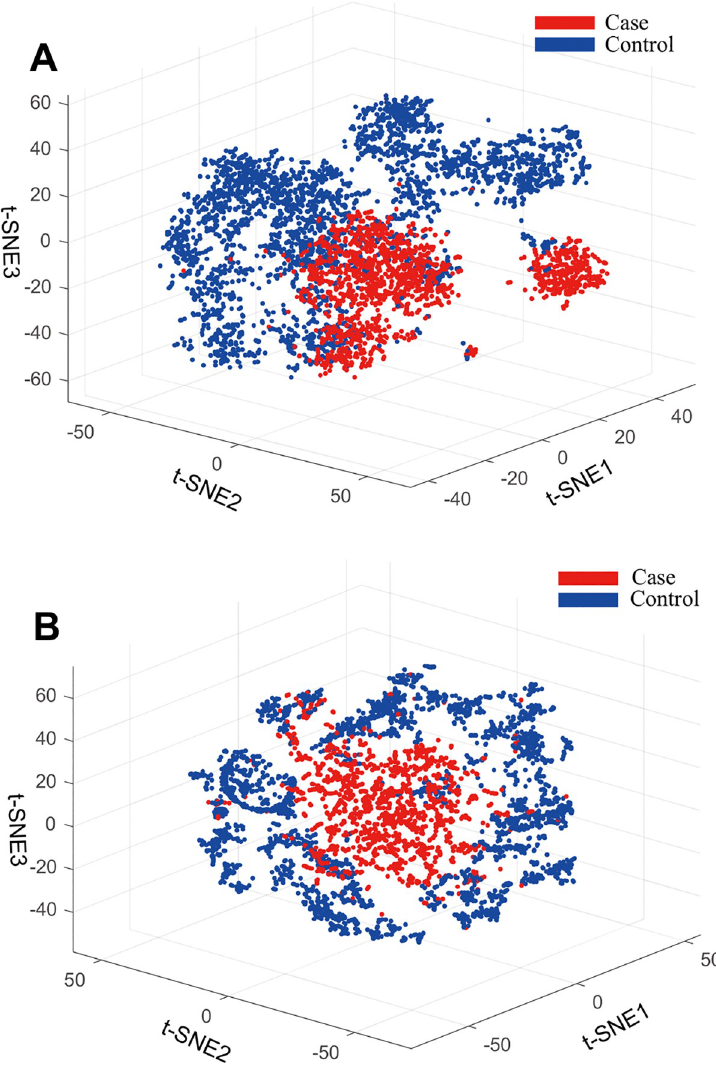
Fig 2. Batch effect elimination by COAC evaluated by a t-SNE algorithm [9]. ( A ) A significant batch effect elimination (Cells distribute separately in different groups) based on the COAC-inferred subnetworks. ( B ) A significant batch effect (Cells distribute uniformly between case and control groups) was observed based on the original scRNA-seq data from a previous study [37], without applying COAC.